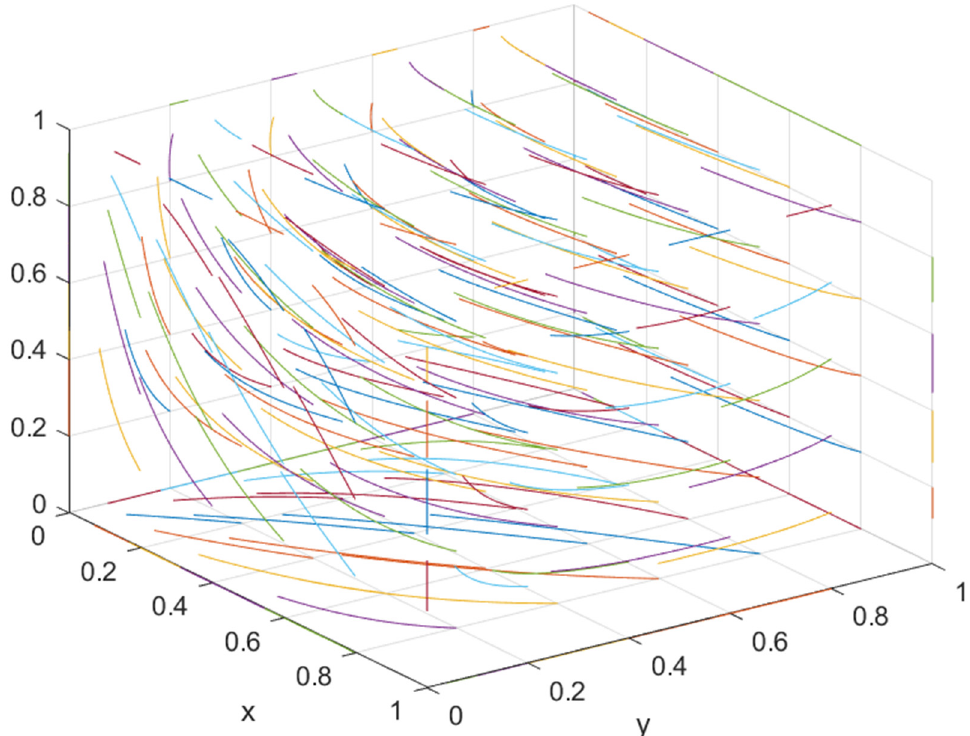
Figure 9. A6 = (0, 1, 1) evolution result.